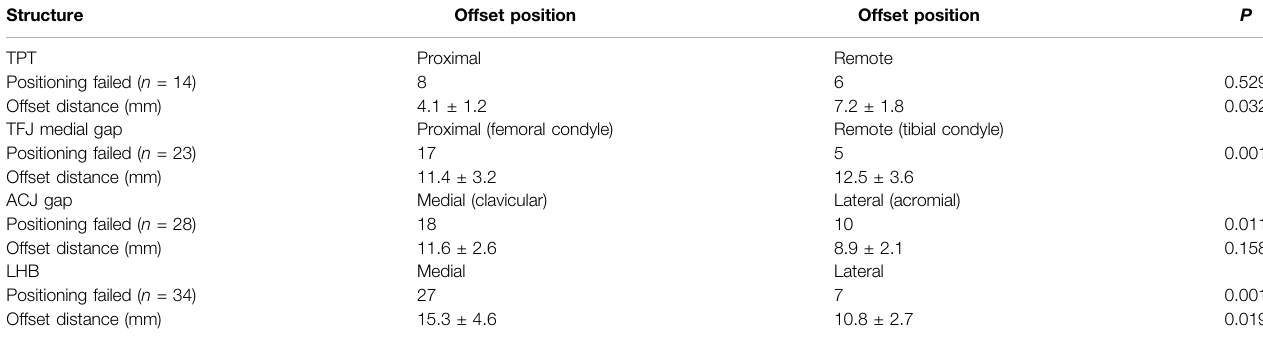
TABLE 4 | Vertical distance between the reference line and given structure.